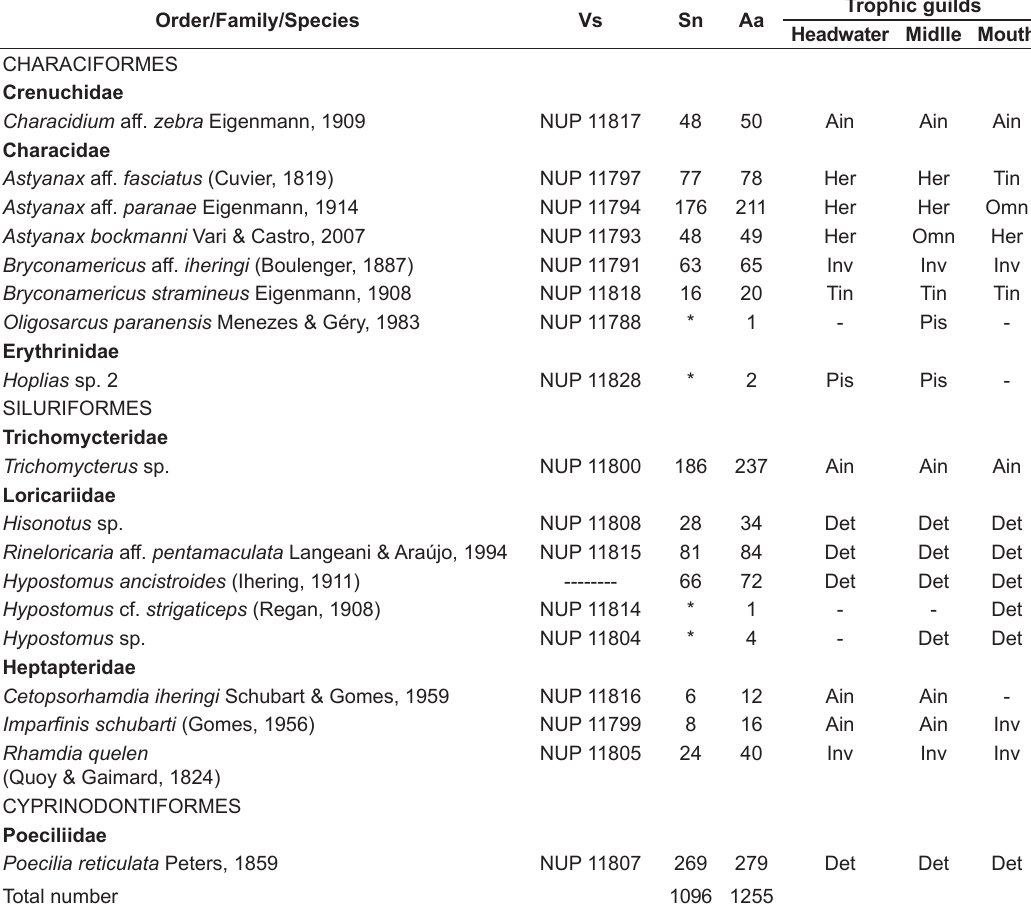
Table 2. Taxonomic position (Reis et al., 2003) and trophic guilds of the species sampled in the Itiz stream.